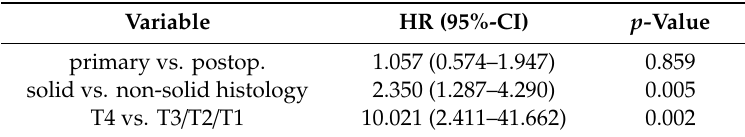
Table 2. Multivariate analysis for local control.